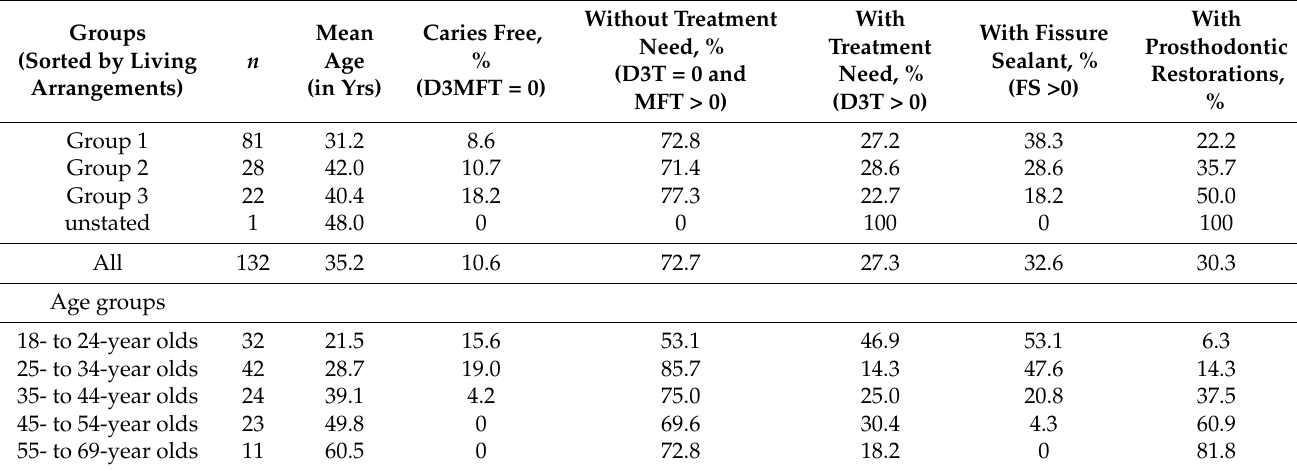
Table 2. Prevalence rates for persons with intellectual disability without caries experience, without treatment need, or with treatment need, in different groups.